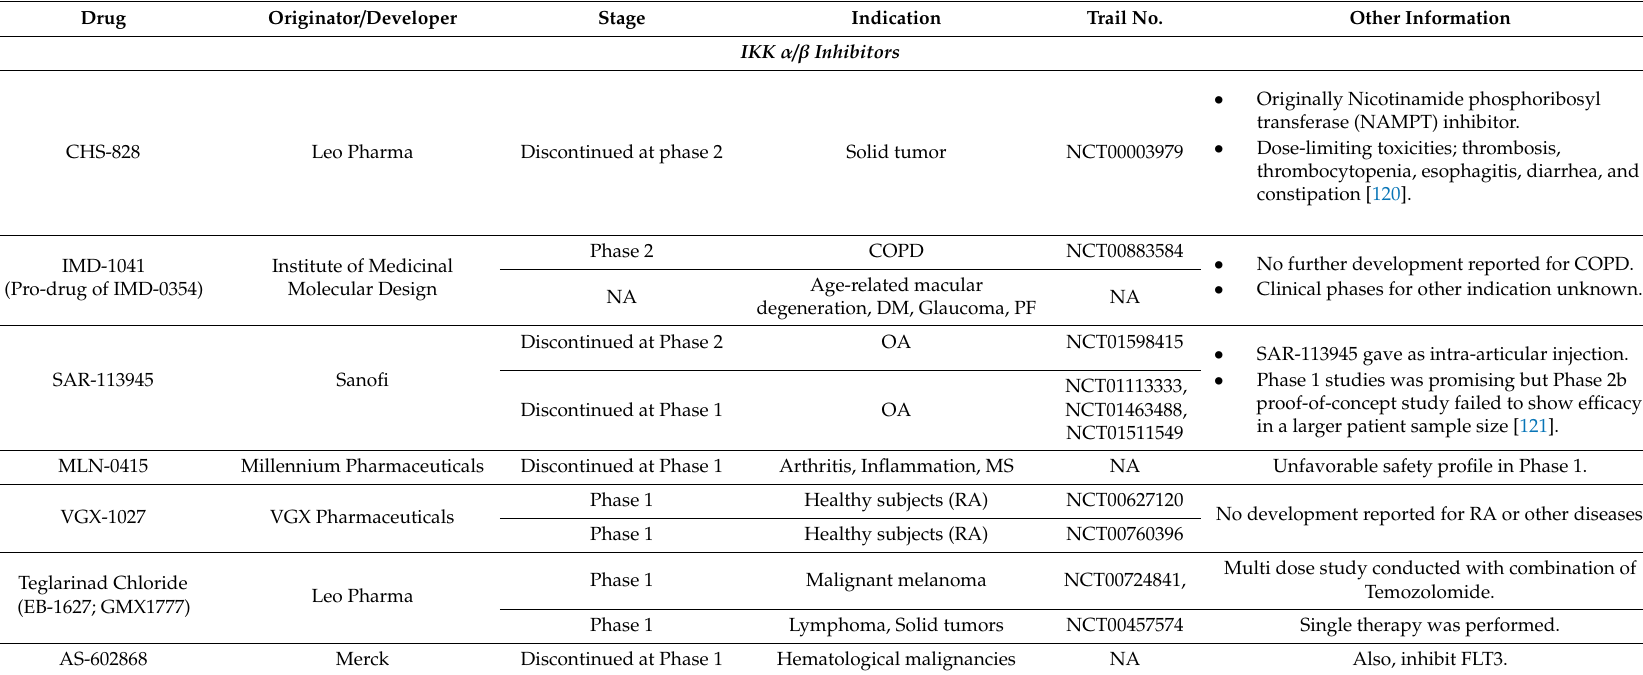
Table 3. Clinical small molecules inhibitors targeting IKK complex in NF- κ B